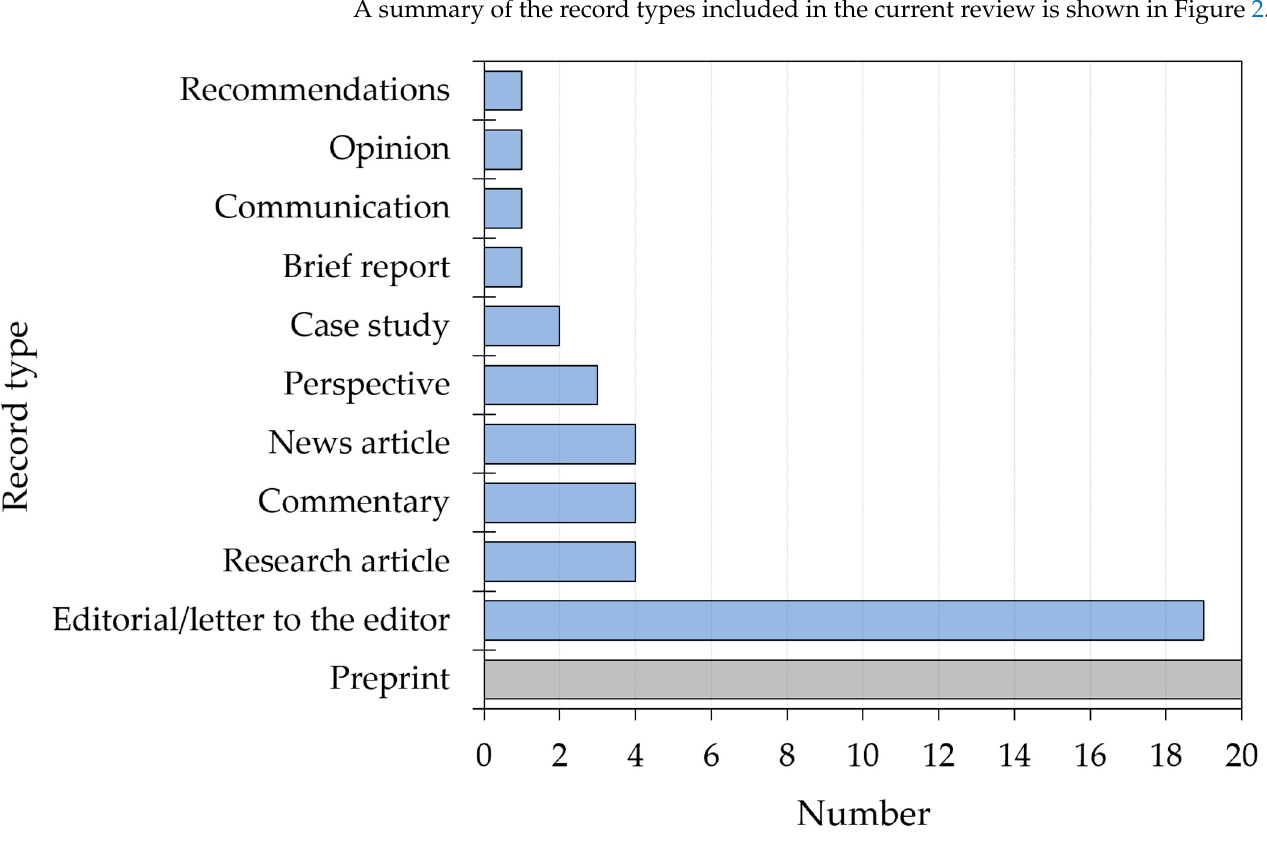
Figure 2. Summary of the types of included records ( n = 60). Preprints (not peer reviewed) are highlighted in grey while published records are highlighted in blue.